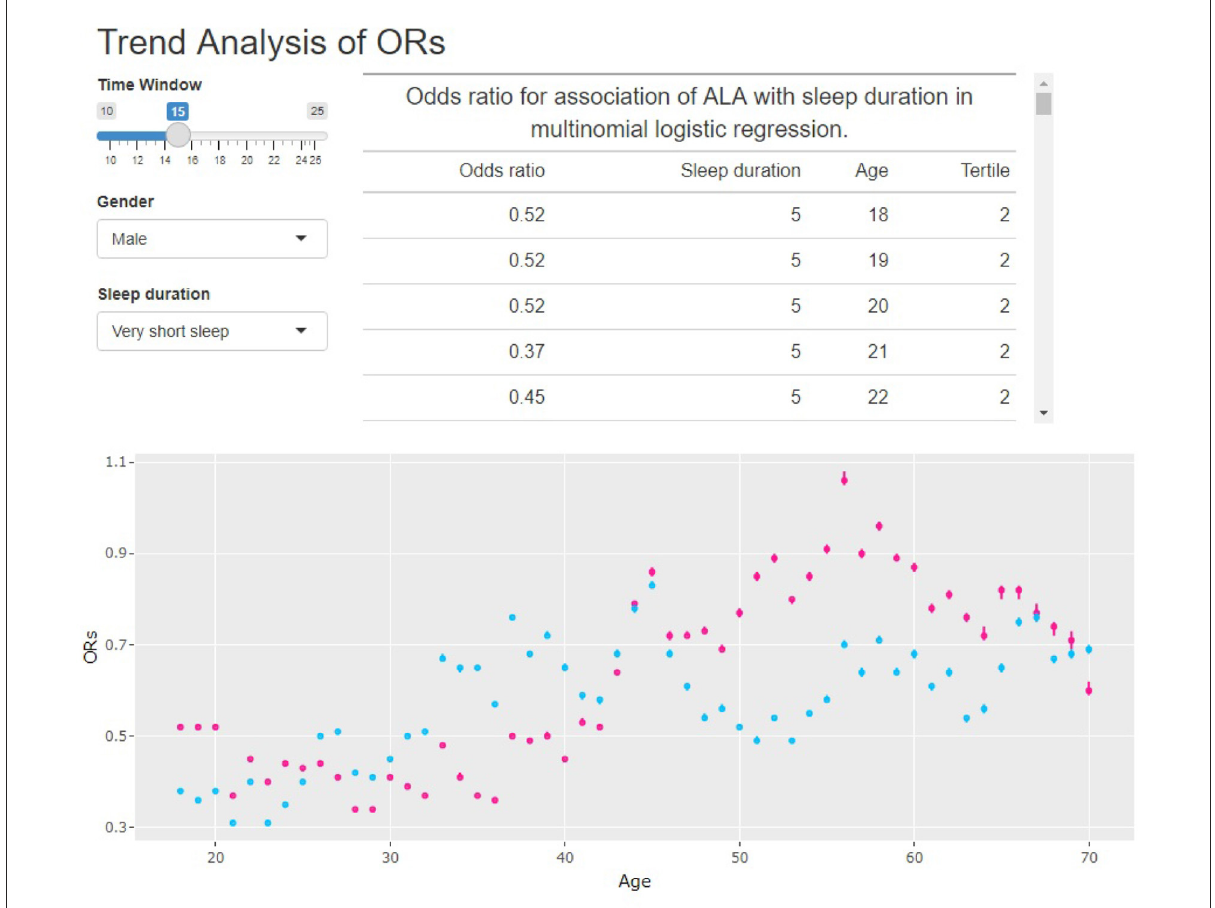
FIGURE6 Interface of the Shiny